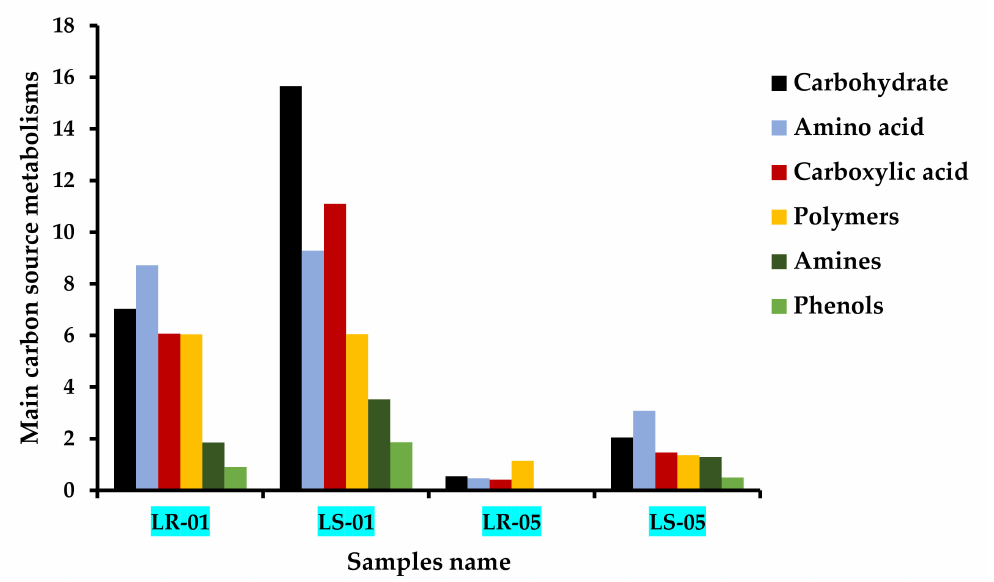
Figure 3. Major carbon source metabolic patterns at the incubation end point (168 h) of all rock and soil samples according to the different sampling zones (LS1 and LR1, outside cave; LS5 and LR5, inside